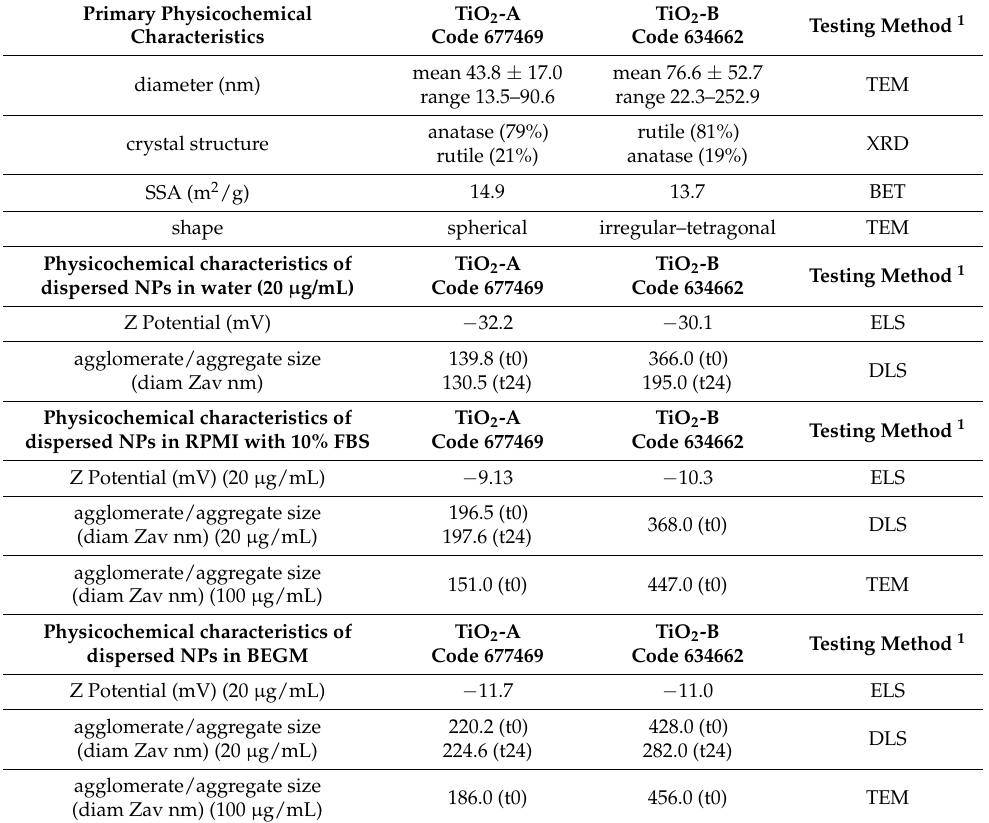
Table 1. Basic properties of the tested TiO 2